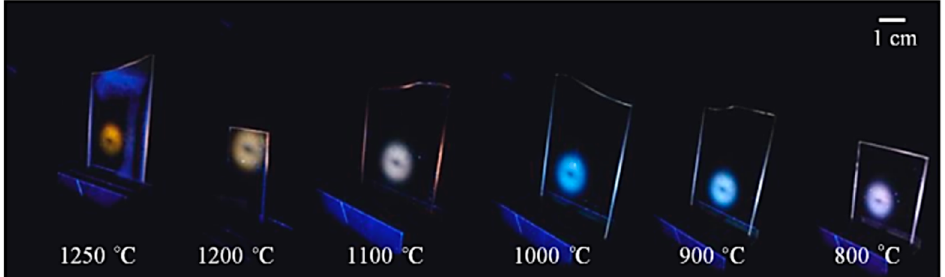
Figure 6. Experimental proof of visible luminescence of the Si-rich SiCO thin films pyrolyzed from 800 °C to 1250 °C under UV laser excitation [79]. 800 ◦ C to 1250 ◦ C under UV laser excitation